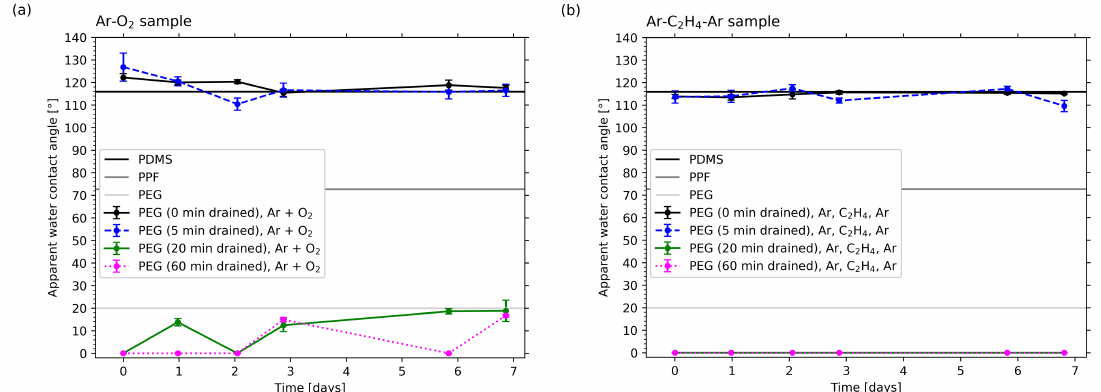
Figure 9. Temporal evolution of the apparent water contact angle on the ( a ) Ar-O 2 and the ( b ) Ar-C 2 H 4 -Ar samples. For comparison the WCA values for pure PDMS, the plasma-polymerized film and PEG are drawn as straight